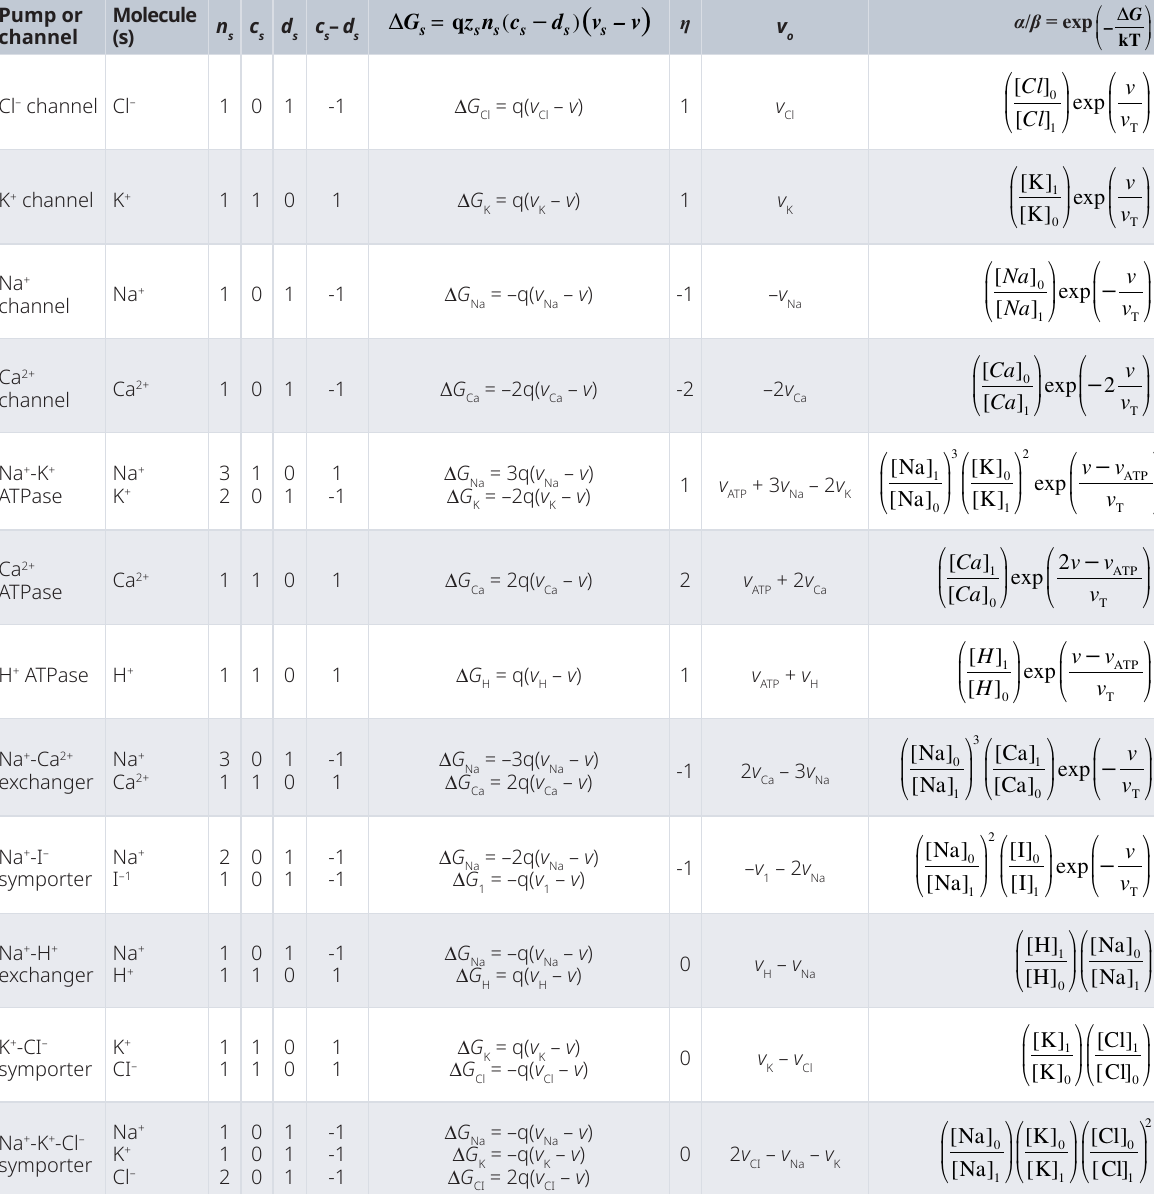
Table 1. Energy required for transmembrane transport mediated by different passive and active mechanisms. Pump or